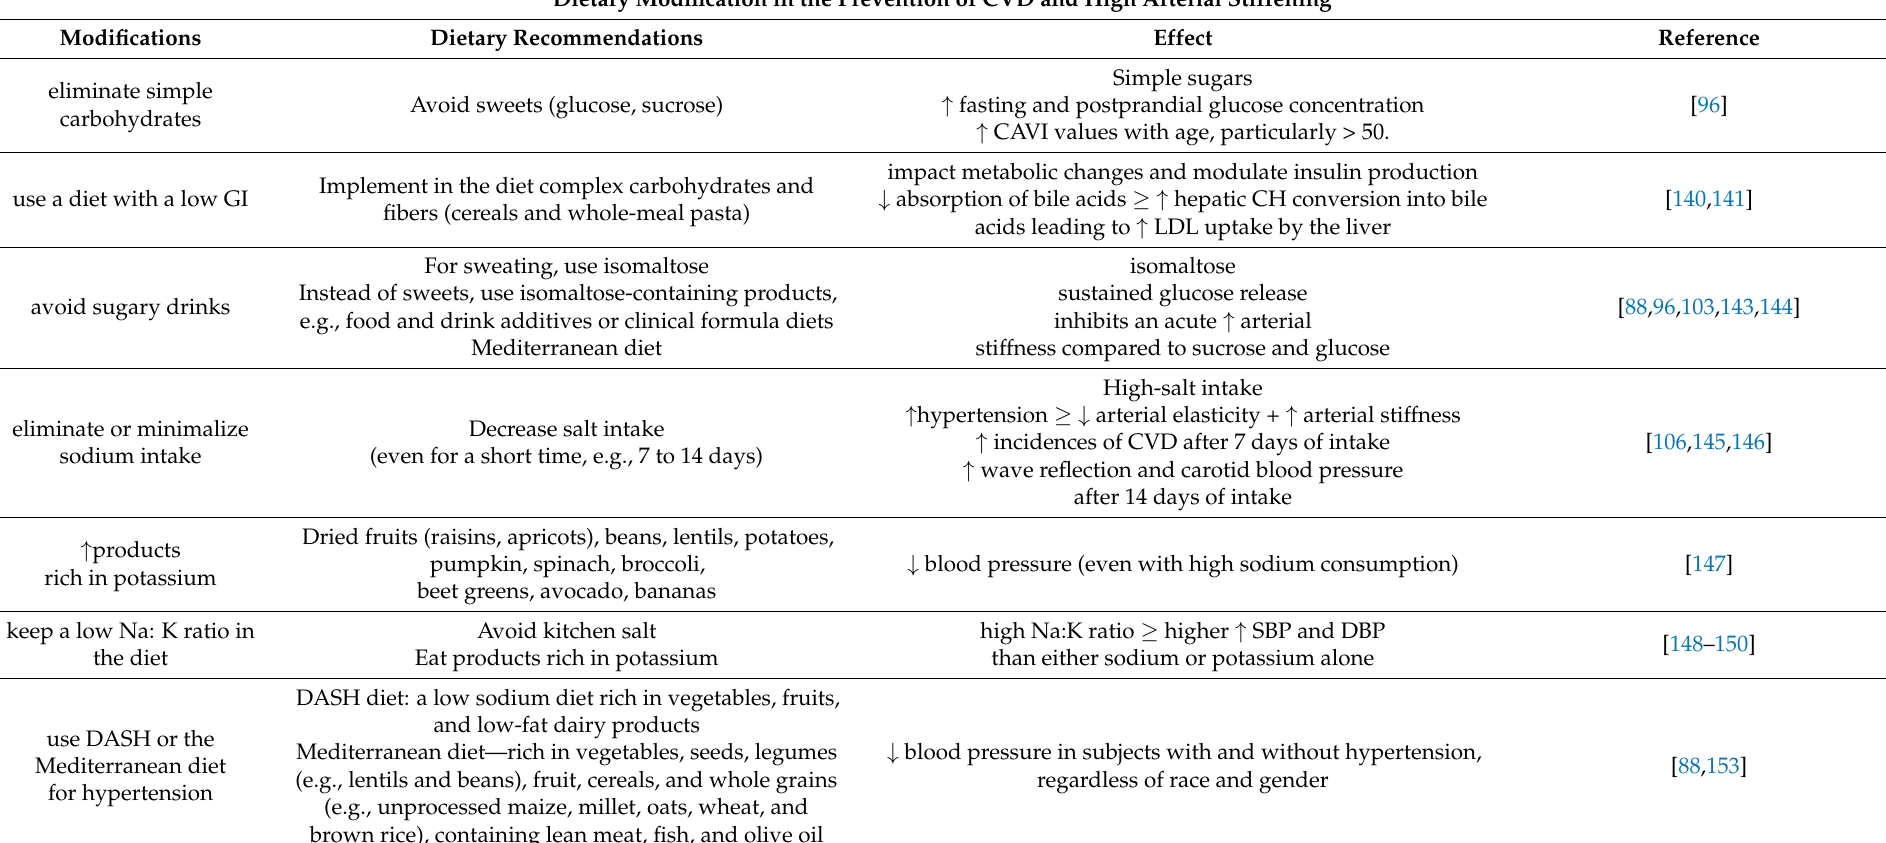
Table 2. Cont. Dietary Modification in the Prevention of CVD and High Arterial